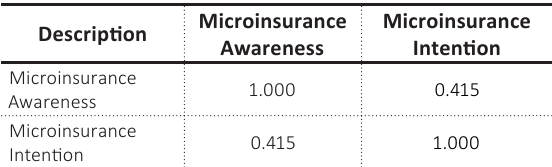
Table 5. Latent variable correlations